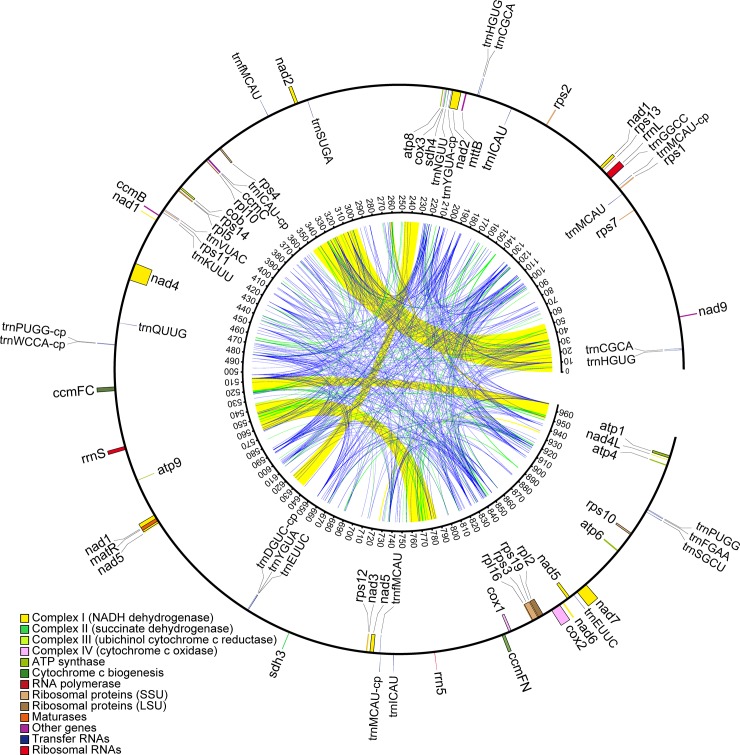
Draft mitochondrial genome map of Magnolia biondii.The total length of the Magnolia draft mt genome is 967,100 bp. Genes (exons are shown as closed boxes) shown outside the curve are transcribed clockwise, whereas those inside are transcribed counter-clockwise. Genes from the same protein complex are colored the same, introns are indicated in white boxes, and tRNAs of chloroplast origin are noted with a ‘-cp’ suffix. Repeat distributions and occurrences are show inside the gene map. Large repeats >1,000 bp in length are indicated in yellow, medium-sized repeats in the range of 100–1,000 bp in length are indicated in green, and small repeats <100bp in length are colored blue. Numbers on the inner curve represent genome coordinates (Kb).